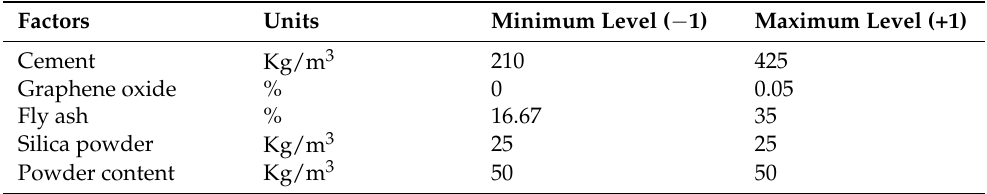
Table 4. Proportioning of powdered materials in